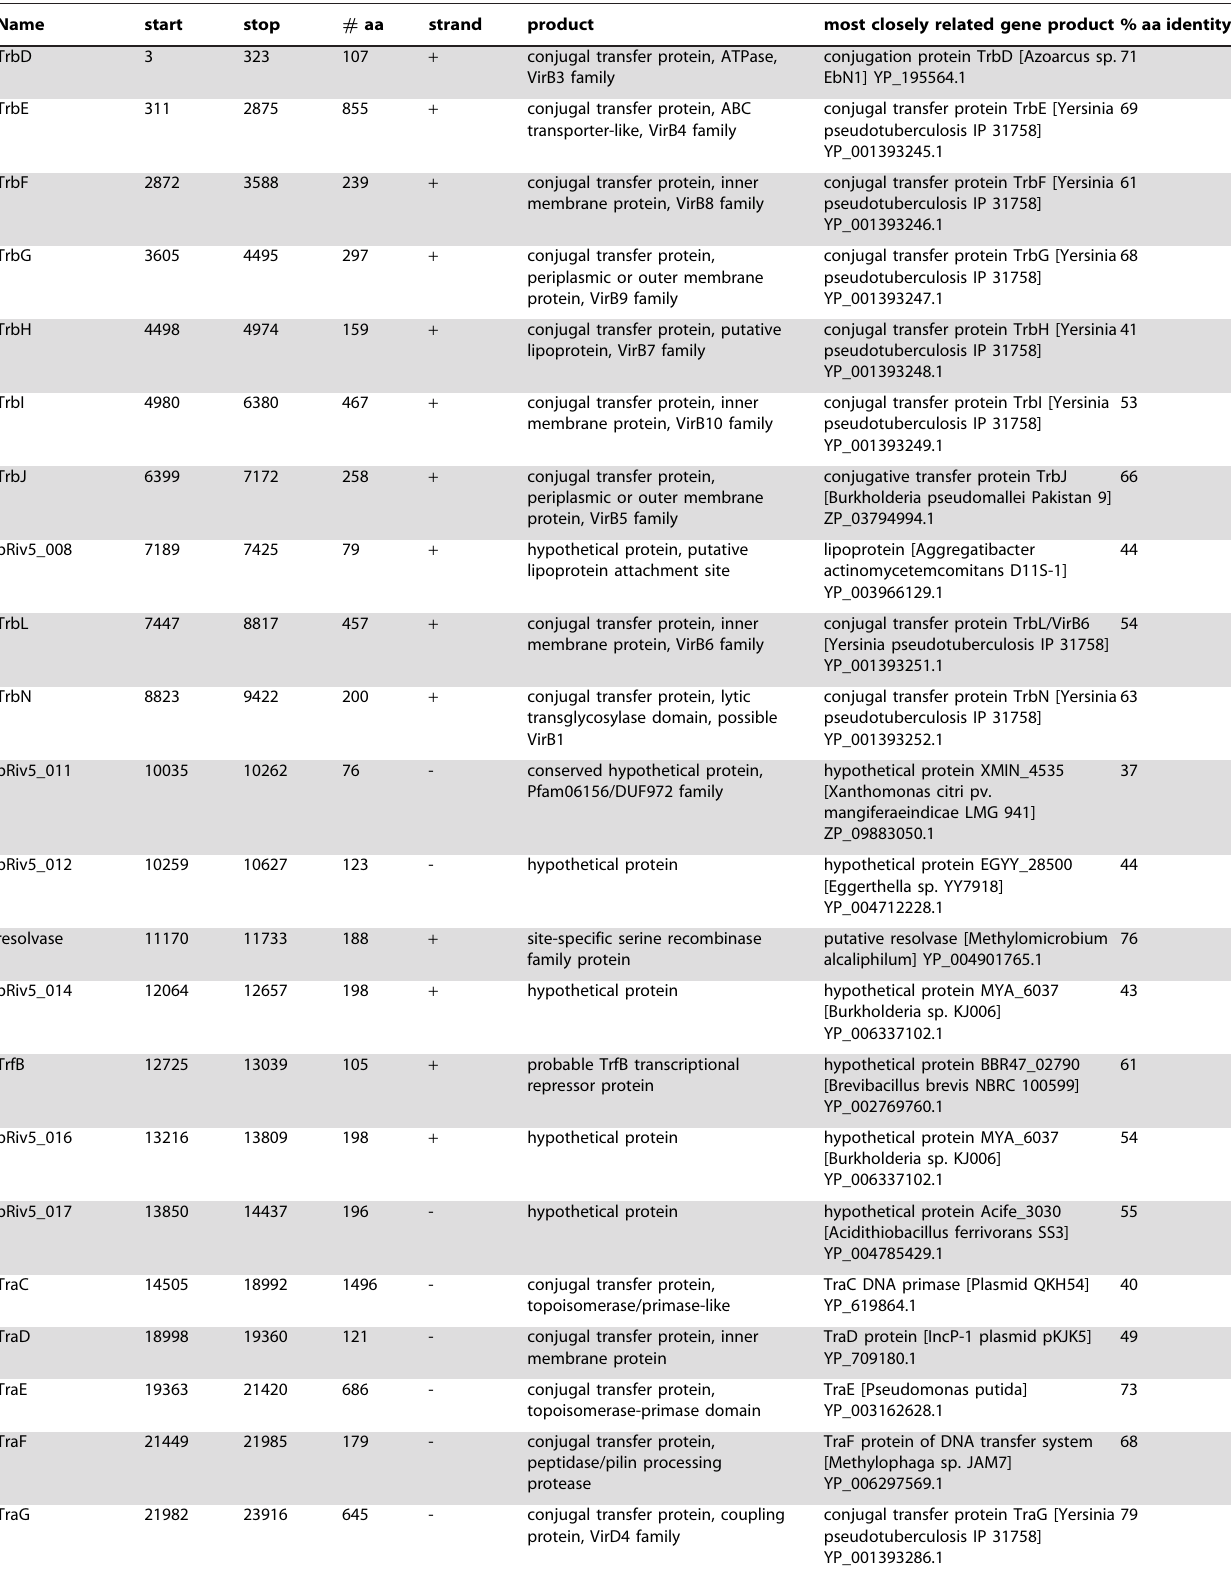
Table 1. Annotation of open reading frames from